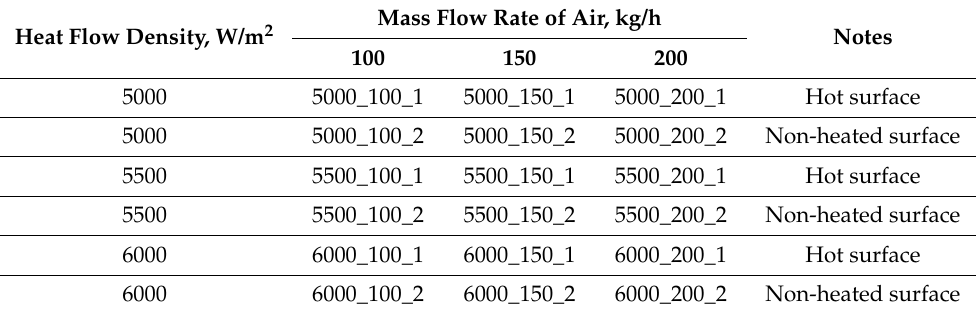
Table 1. Plan for performing the numerical experiment with one-sided heat input.